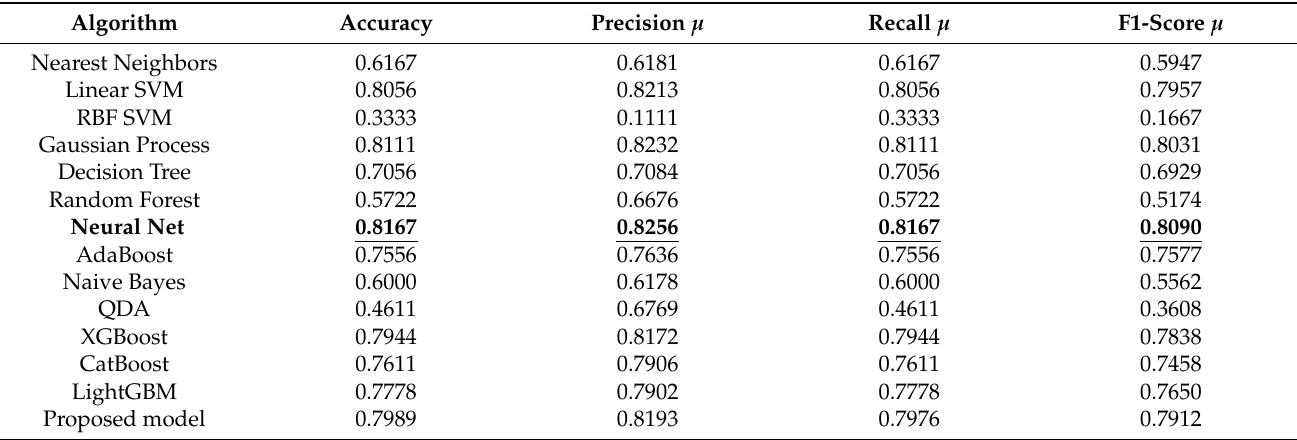
Table 7. Age classification of Hatsuboshi rice